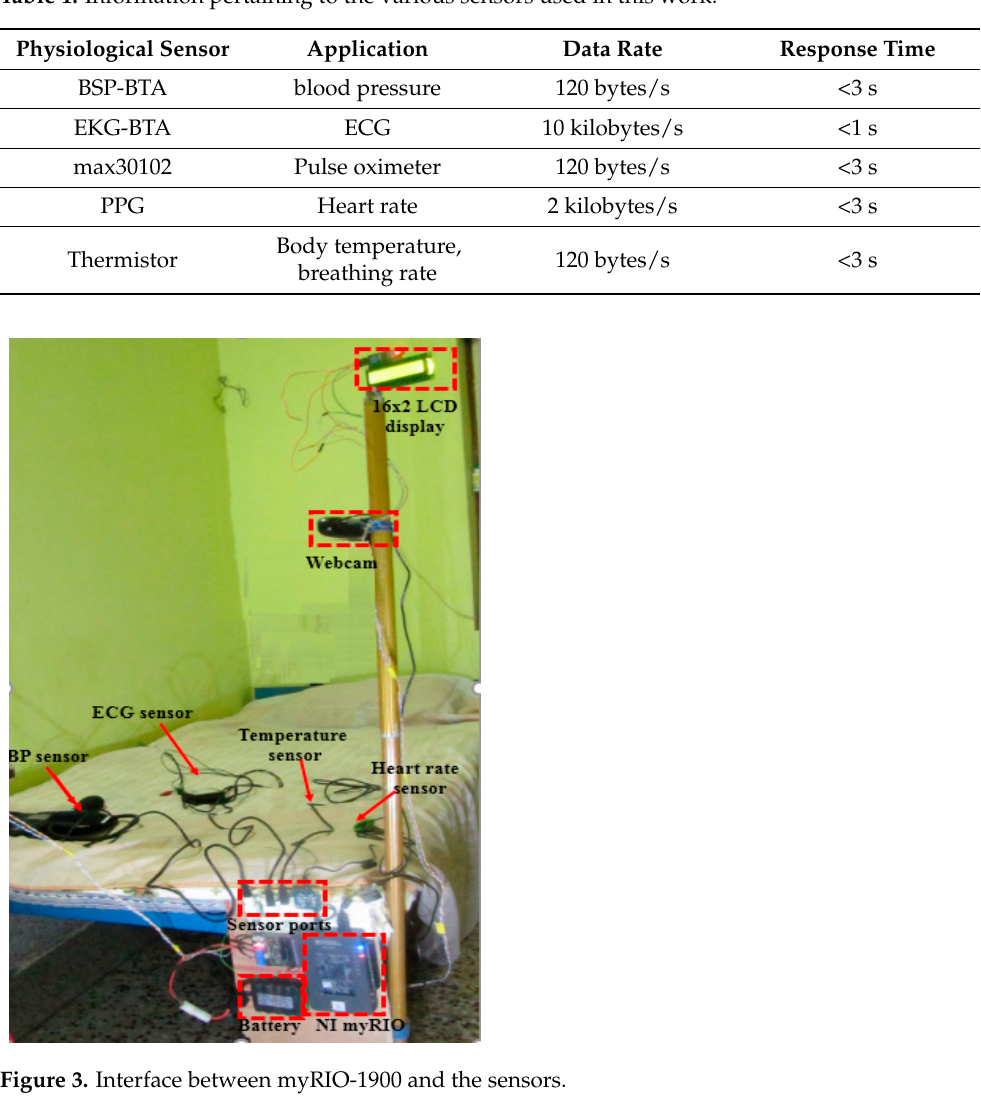
Figure 4 . Pin diagram for interconnections between myRIO-1900 and the sensors .